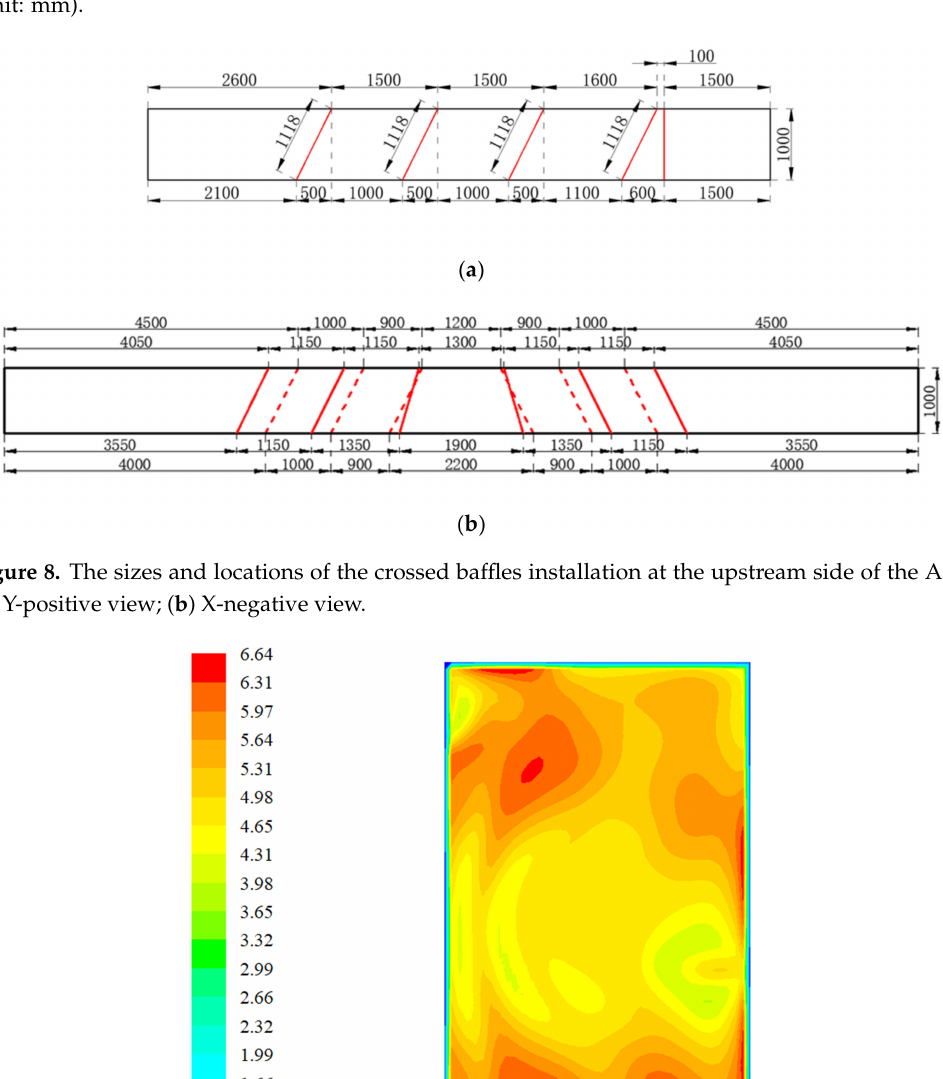
Figure 7. The crossed baffles installation at the upstream side of the ammonia injection grid (AIG) (unit: mm).